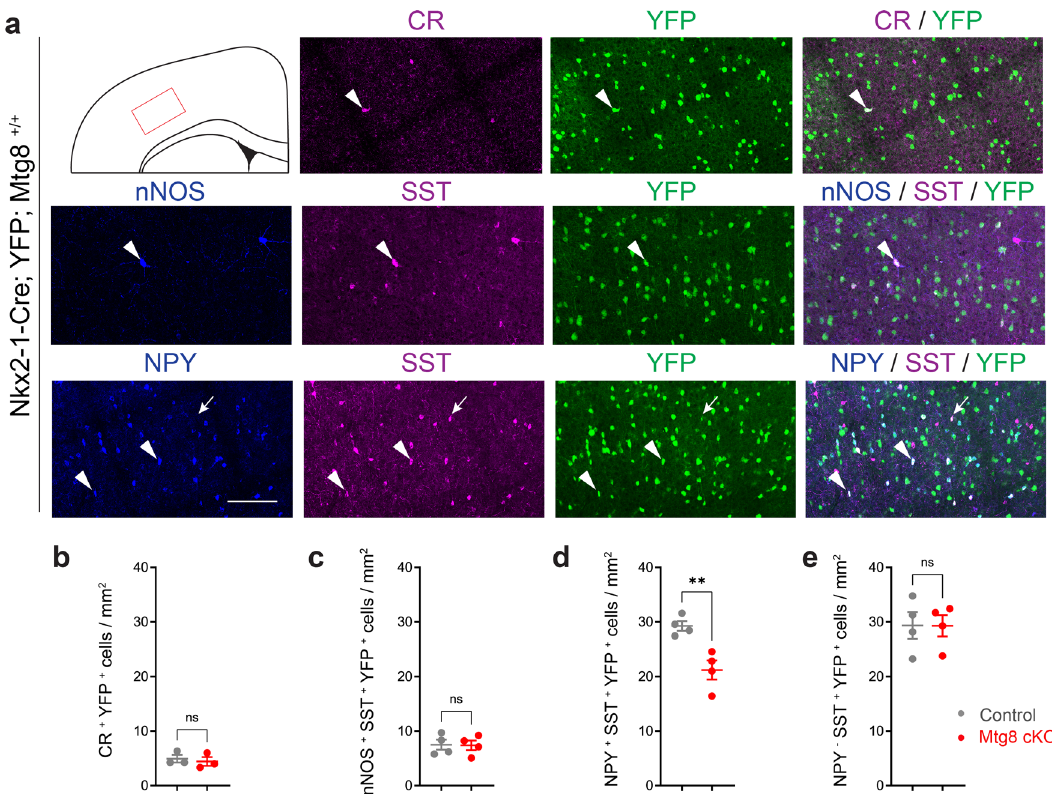
Fig. 8 | Mtg8 is required for speci fi cation of cortical SST-NPY interneuron subsets. a Immunohistochemistry detecting co-expression of CR/YFP or nNOS/ SST/YFP or NPY/SST/YFP in the somatosensory cortex in control animals at P40. Arrowheads point to double-labelled cells for CR/YFP and triple-labelled cells for nNOS/SST/YFP and NPY/SST/YFP. Arrows point to double-labelled SST/ YFP cells. b – e Quanti fi cation of the above co-expression pro fi les in control and